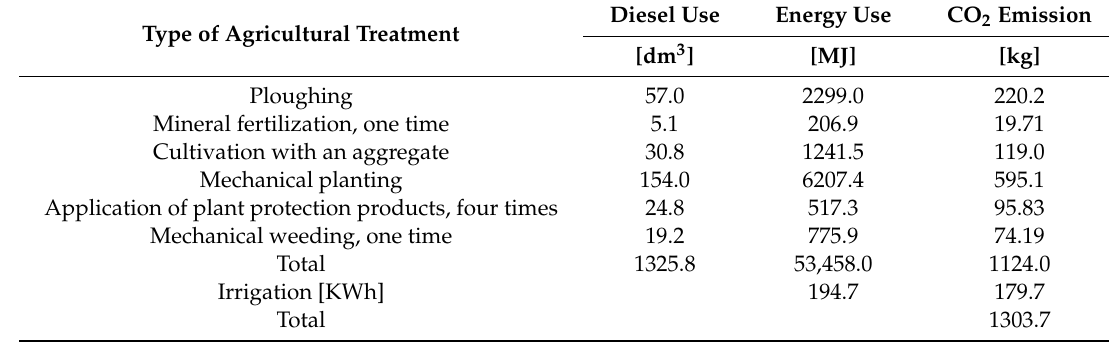
Table 3. Energy consumption and greenhouse gas (GHG) emissions associated with agricultural treatments.